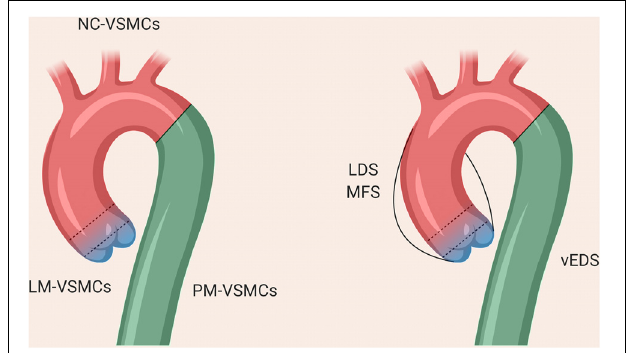
FIGURE 2 | The different regions of the thoracic aorta and their disease susceptibilities. The descending aorta comprises VSMCs from paraxial mesoderm, the aortic arch from neural crest, and the aortic root from lateral plate mesoderm. The boundary between the arch and descending aorta is clearly defined, whereas there is overlap between the VSMCs from NC and LM at the aortic root, as denoted by the dotted